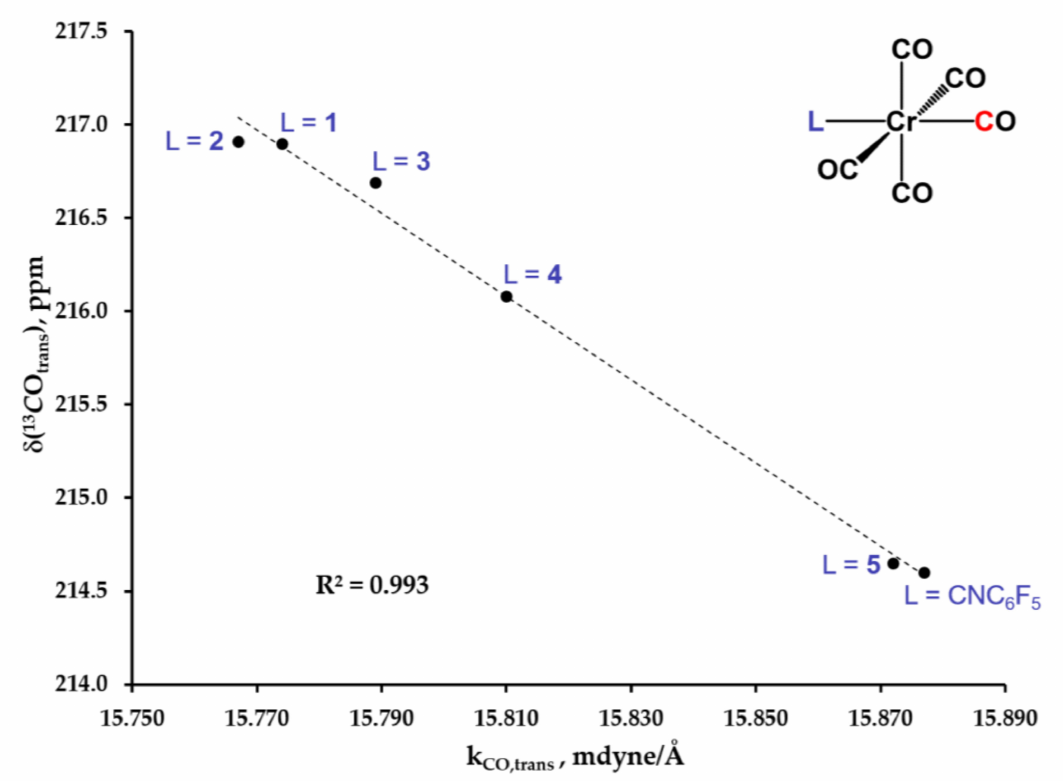
Figure 9. Plot of 13 C NMR chemical shifts δ ( 13 CO trans ) vs. k CO,trans for the series of complexes 6 , 7 , 8 , 9 , 10 , and [(OC) 5 Cr(CNC 6 F 5 )] [12]. All 13 C NMR data were recorded for solutions in CDCl 3 . The IR spectra of 6 , 7 , 8 , 9 , and 10 were recorded for solutions in CH 2 Cl 2 , and the IR spectrum of [(OC) 5 Cr(CNC 6 F 5 )] was obtained for a solution in pentane. Recently, we demonstrated the utility of 13 C NMR δ ( 13 CO trans ) or δ ( 13 CO cis ) vs. δ ( 13 CN) inverse-linear correlations in assessing the π -acceptor/ σ -donor capabilities